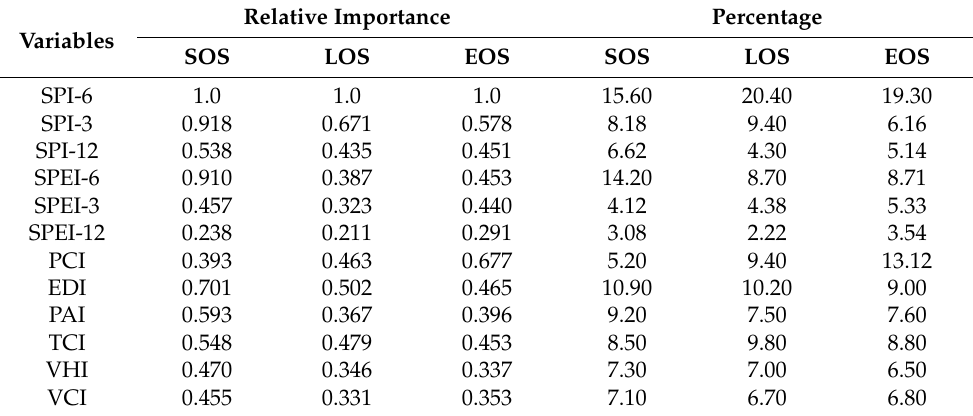
Table 6. Contribution of each input variable to the output function of the model. The relative importance indicates how changes in the explanatory variables are linked to shifts in the response variable of the model and the percentage represent the corresponding contribution of the variables.